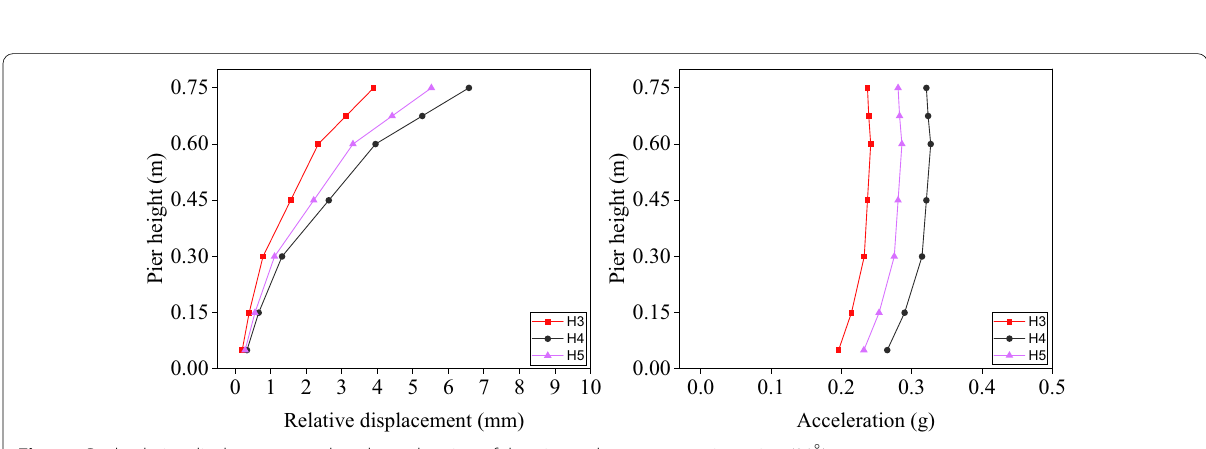
Fig. 15 Peak relative displacement and peak acceleration of the pier under structure orientation ( 30